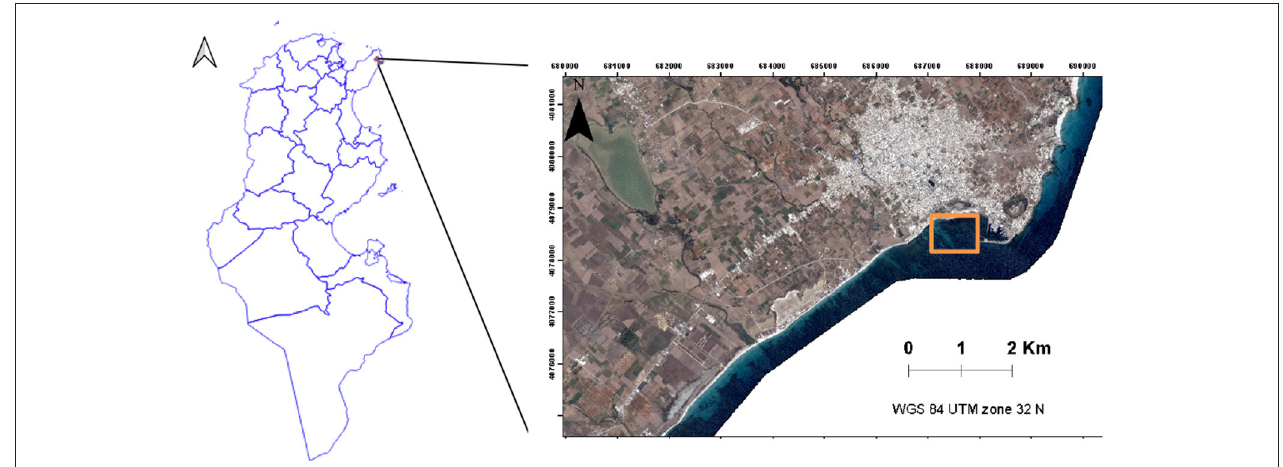
FIGURE 1 | Location of the study area: Kelibia city (right) with regard to the government area boundary of Tunisia